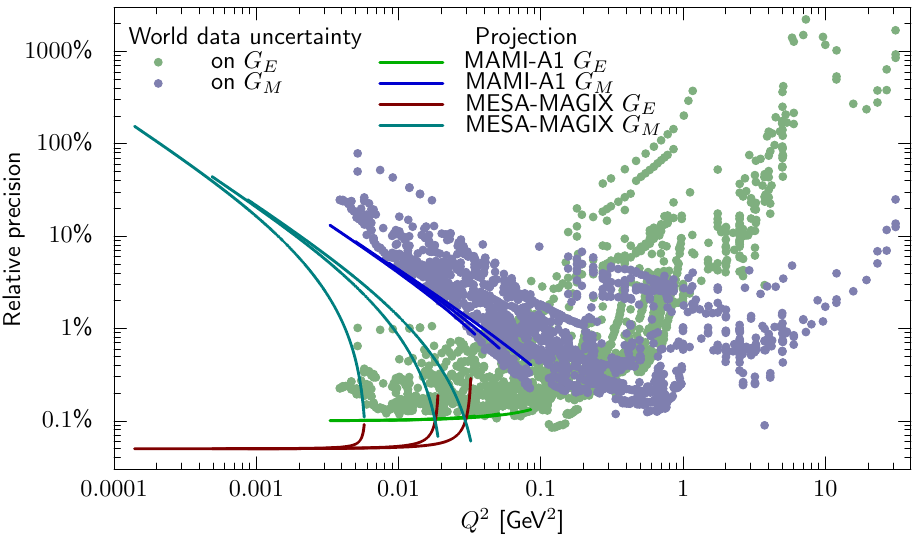
Figure 3. E ff ective uncertainty on the form factors of existing cross section data (points), and projections for the A1@MAMI and MAGIX@MESA experiment (lines). At small Q 2 , the cross section is fully dominated by G E except for extreme backward